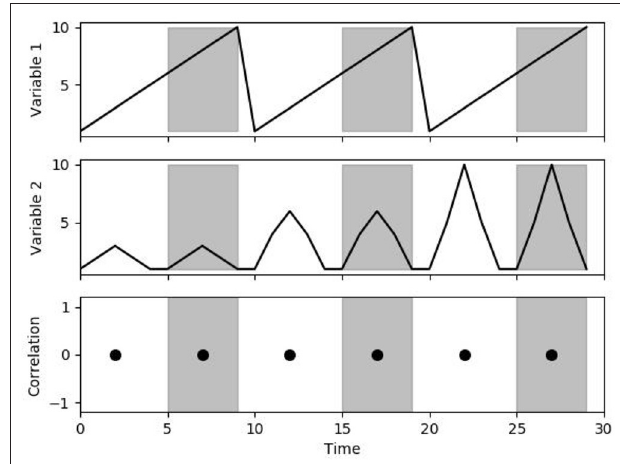
FIGURE 1 | Correlation as a change in multiplicative scaling. The figure demonstrates the correlation between variables 1 and 2 over a 5-s time window. Note that despite the change in scaling, the correlation is always 0 (linearity is preserved).